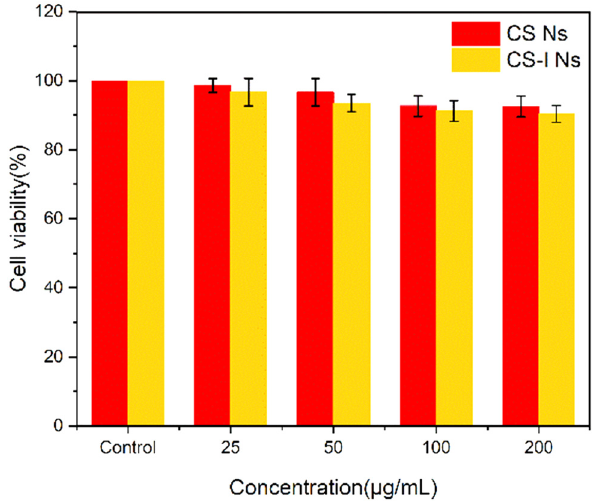
Figure 5: The in vitro cytotoxicity of CS and CS - I Ns.